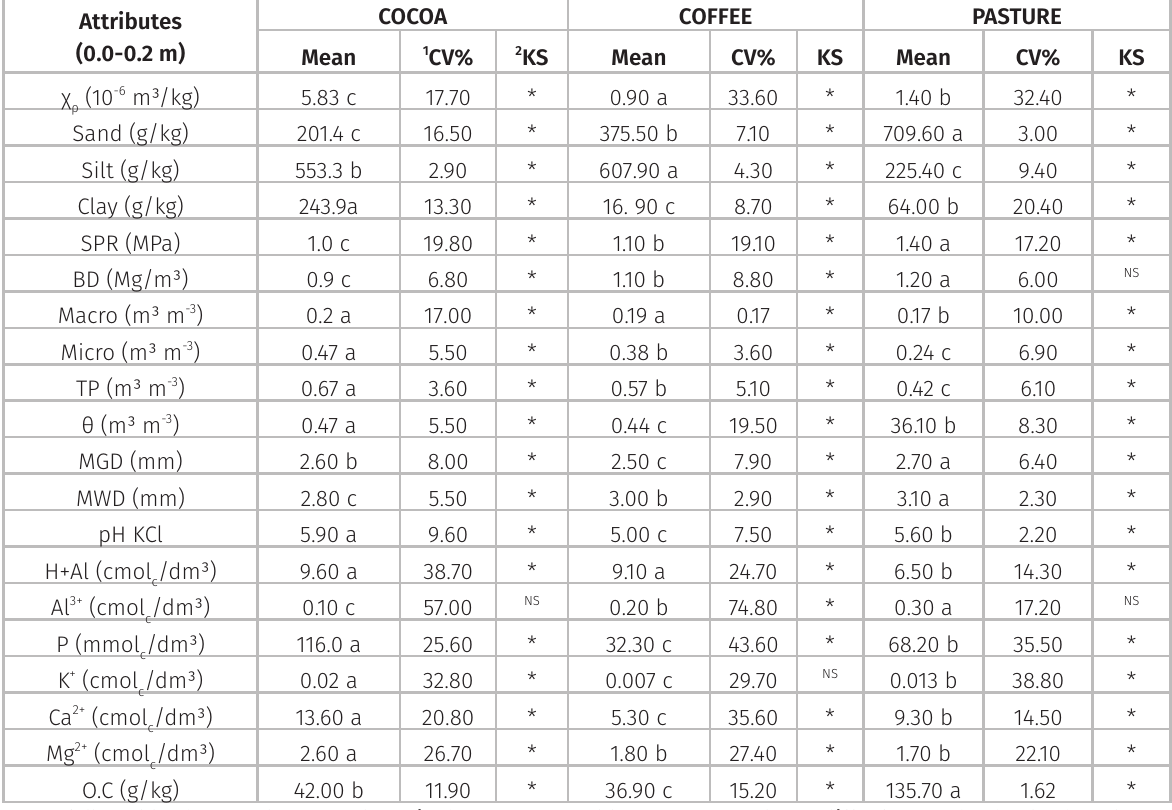
Table I. Descriptive statistics and Tukey averages test at 5% of the analyzed variables of soil attributes and magnetic susceptibility in areas of Indian Black Earth under uses with cocoa, coffee and pasture.